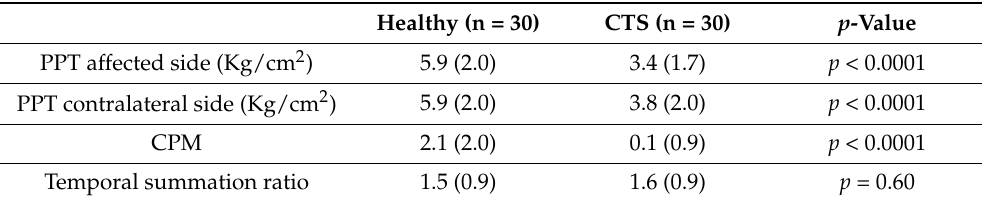
Table 2. Variables indicative of changes in central pain processing.